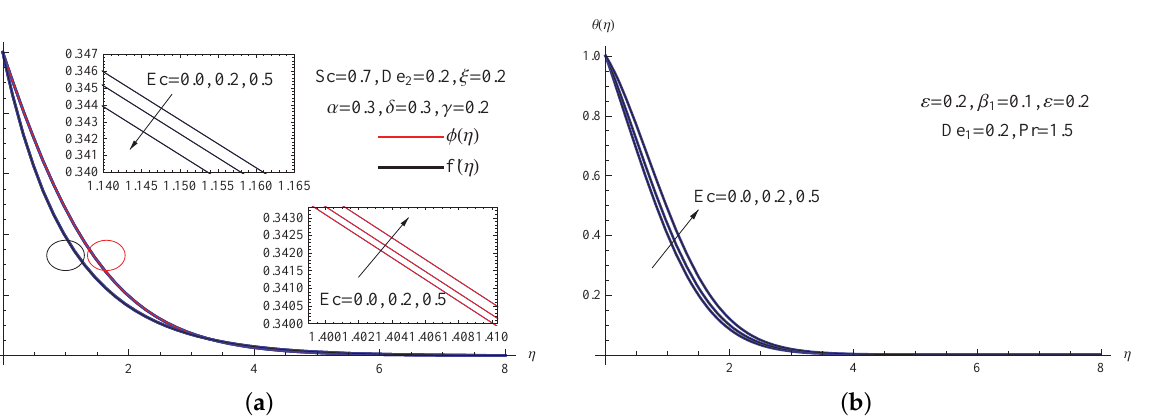
Figure 7 demonstrates the impact of the Eckert number Ec on the velocity f (cid:48) ( η ) , thermal θ ( η ) and concentration φ ( η ) profiles. The upsurge in Eckert number Ec clearly works by improving both the thermal boundary thickness and the temperature profile. Further, a barely noticeable upgrade for the concentration profiles φ ( η ) is made due to the Eckert number Ec , while the inverse marginally noticeable pattern is noticed for the speed profile f (cid:48) ( η ) . In physical terms, due to the dissipation phenomena, enhancing the value of Ec causes more heat energy to be created. This could explain why the temperature distribution within the thermal boundary layer is improving.